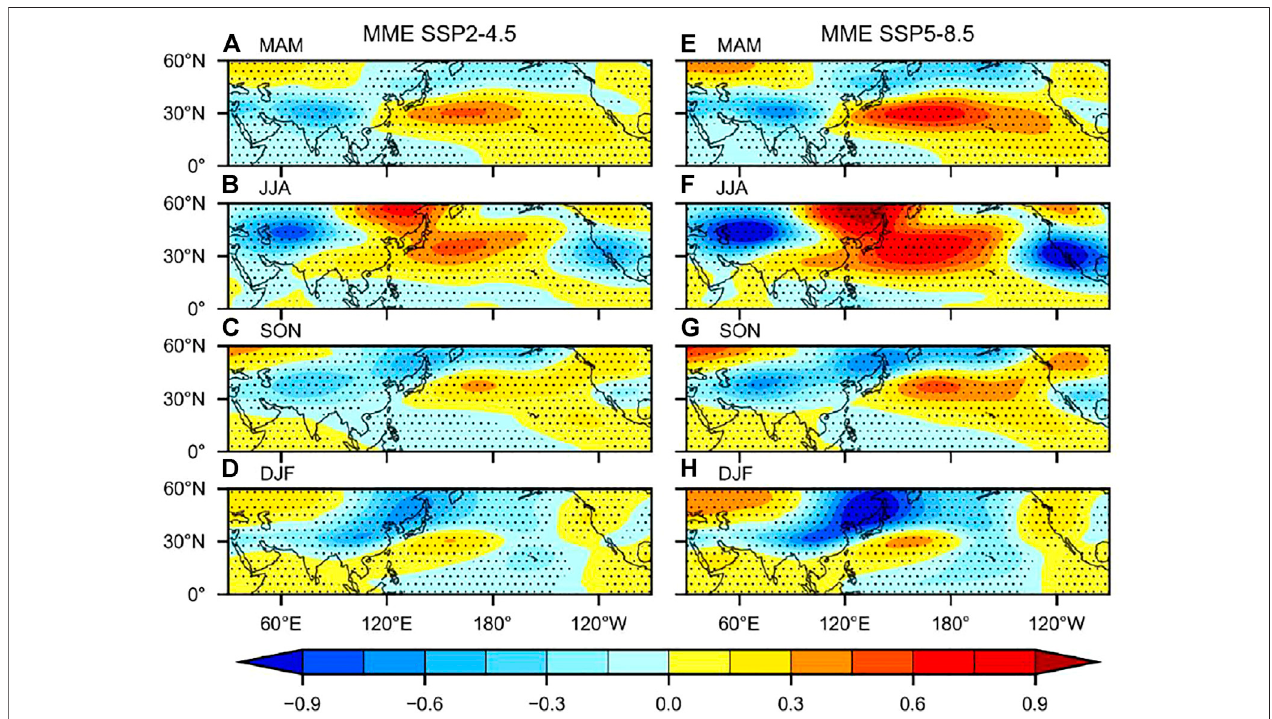
FIGURE 7 | MME projected changes of (A,E) spring, (B,F) summer, (C,G) autumn and (D,H) winter UTT (unit: ° C) during 2050 – 2099 relative to 1965 – 2014 under (A – D) SSP2-4.5 and (E – H) SSP5-8.5. Regions above the 95% signi fi cance level are dotted.